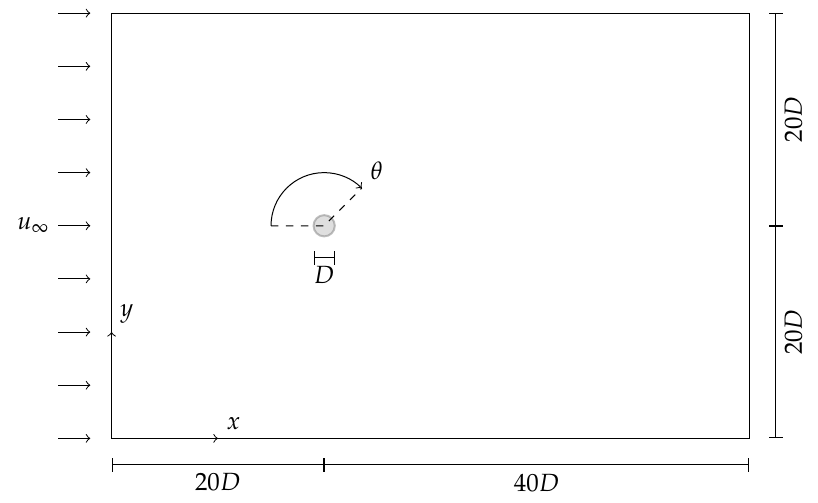
Figure 25. Geometry considered for the case of flow around a cylinder.